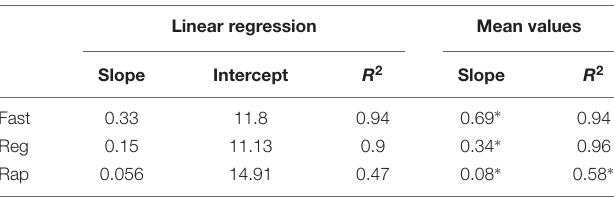
Left columns, slope, intercept and R 2 derived from the linear regression computed from the mean I/F data for each neuronal type according to their firing patterns and location. Right columns mean I/F parameters obtained from the individual slope and R 2 values from I/F curves for each recorded neuron. ∗ p <